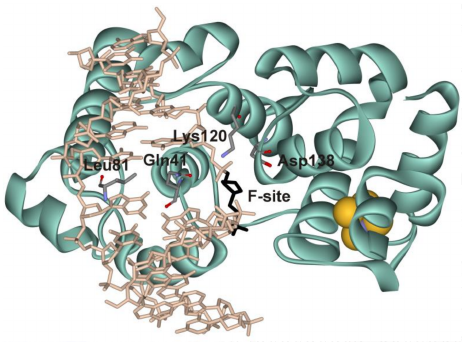
Figure 1. The structures of Endonuclease III (Endo III) from Geobacillus stearothermophilus complexed with DNA containing an F abasic site analog (PDB ID 1P59). The F nucleotide (black) everted into the active site of the enzyme. The catalytic Lys120 and Asp138 and void-filling Gln41 and Leu81 amino acid residues are labeled (numbers are given for the Escherichia coli